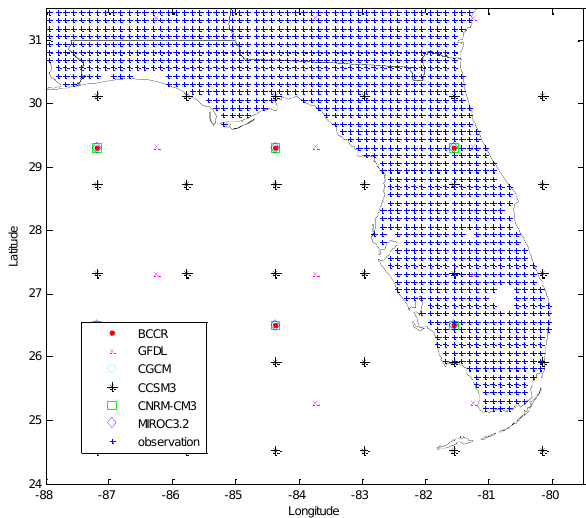
Fig. 1. The study domain and the center location of grids for the GCMs and gridded observation data used in the study. Note that the grid resolutions and configurations for BCCR, CGCM, CNRM- CM3, and MIROC3.2 are